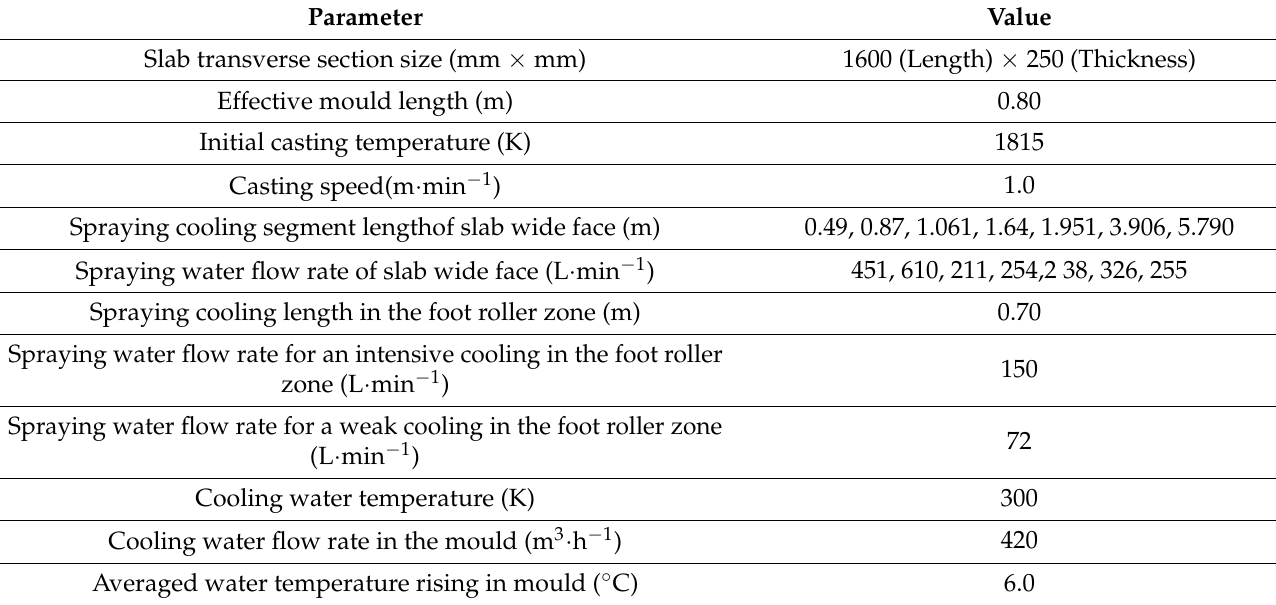
Table 3. Casting process parameters adopted in the